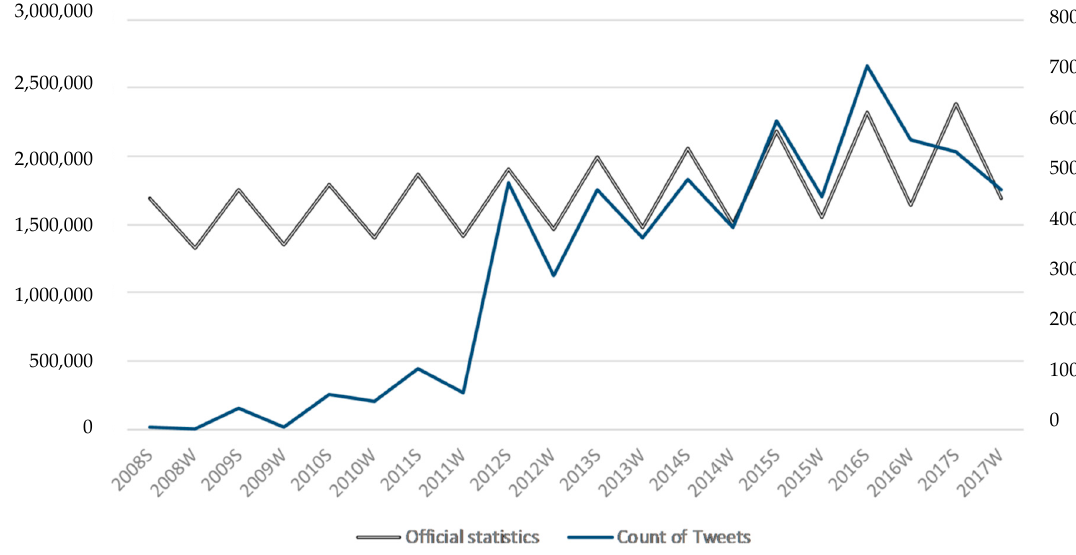
Figure 11. Comparison of absolute numbers of arrivals (from official statistics) and crowdsourced tweets for the evaluation period—for winter and summer season. Summer season is denoted with the suffix “S” and winter season with the suffix “W”. The number of arrivals is denoted as grey line, whereas the absolute number of tweets is depicted as blue line. The x-axis on the left shows the number of arrivals from the official statistics, whereas the right x-axis denotes the absolute number of tweets.